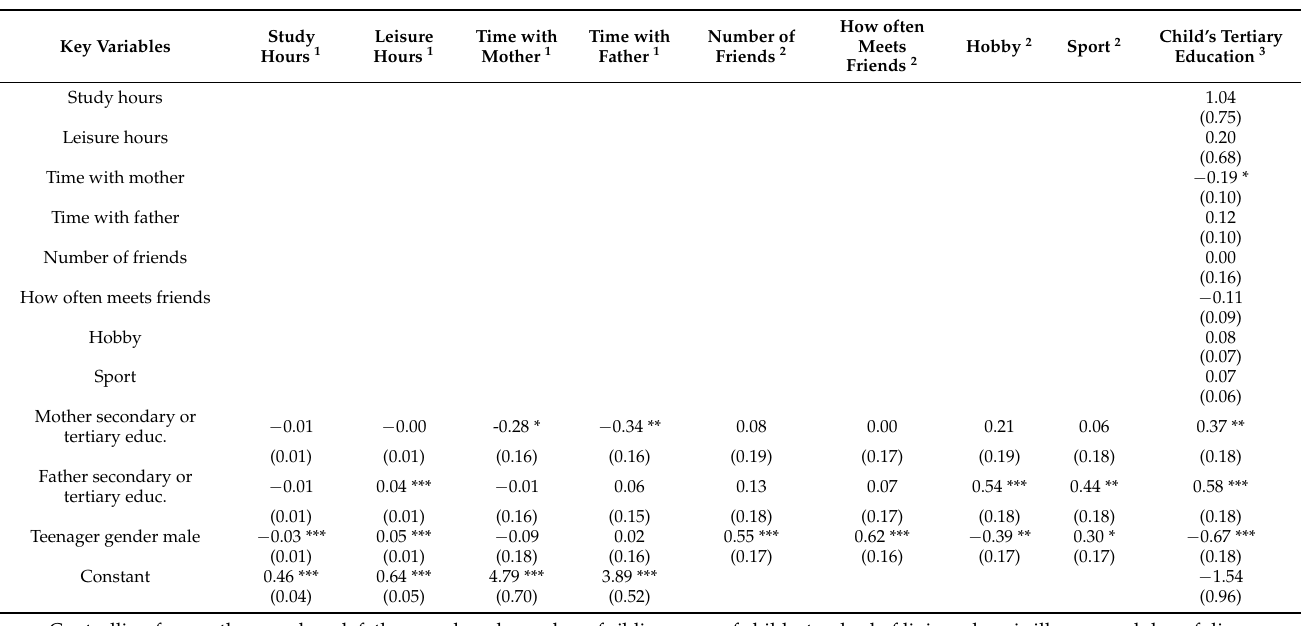
Table 2. Generalised structural equation model (GSEM) on young people’s time use and educational achievement. FTUS 1979, young people aged 10–18. First step models tested for the teenager’s time use and social connectedness in 1979, n = 759. Full model tested for education achieved by 40, n =